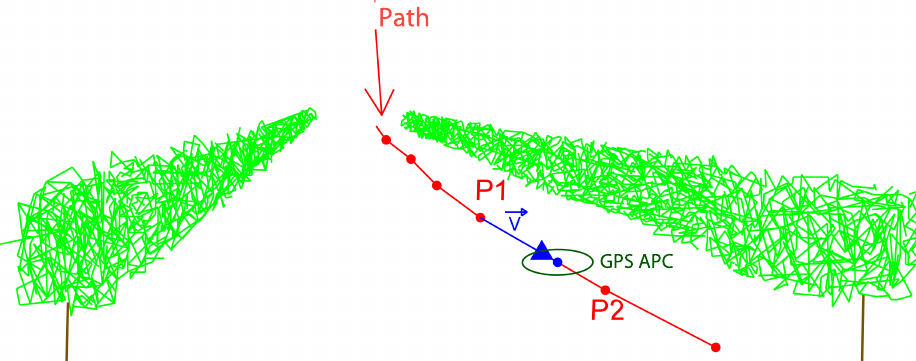
Figure 4. GPS antenna phase center (APC) position interpolated between P1 and P2